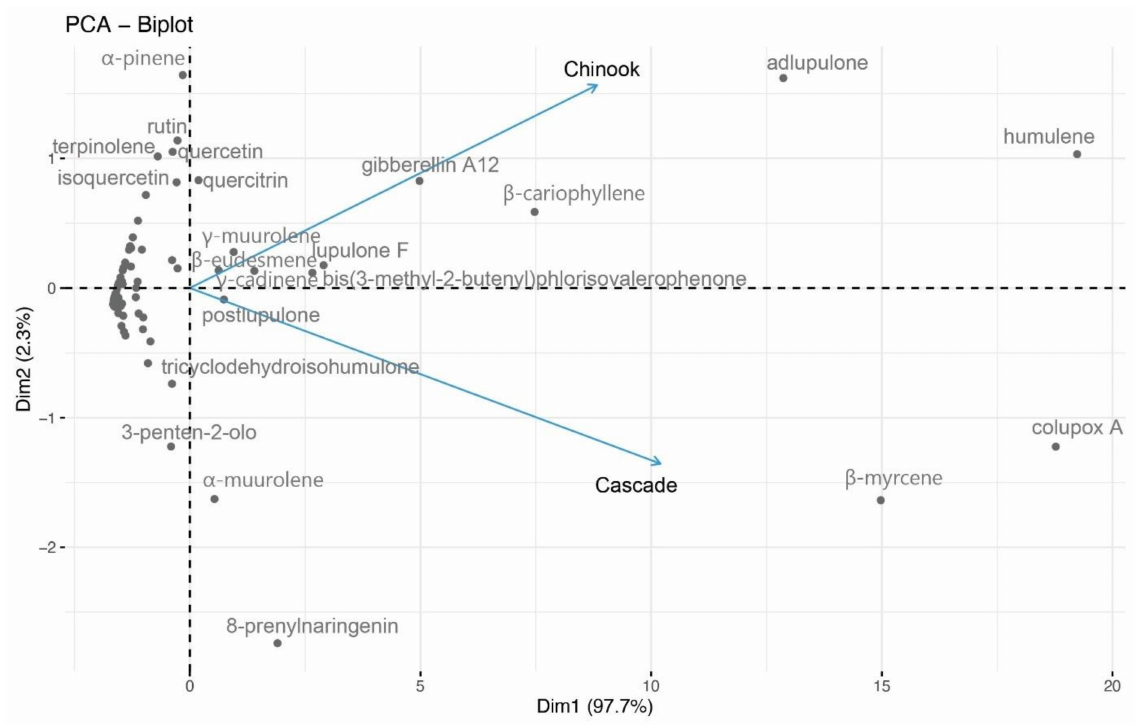
Figure 6. Principal component analysis (PCA) biplot. A biplot provides information on both metabo- lites and samples of a data matrix to be displayed graphically. Arrows represent the two samples Cascade and Chinoook; points represent all metabolites dataset. Compounds responsible for the divergence between the two inflorescences from hop cultivars were adlupulone, humulene and β -cariophyllene for Chinook and β -myrcene and colupox A for Cascade. Metabolites grouped at the origin of the graph do not contribute to the samples’ variability.